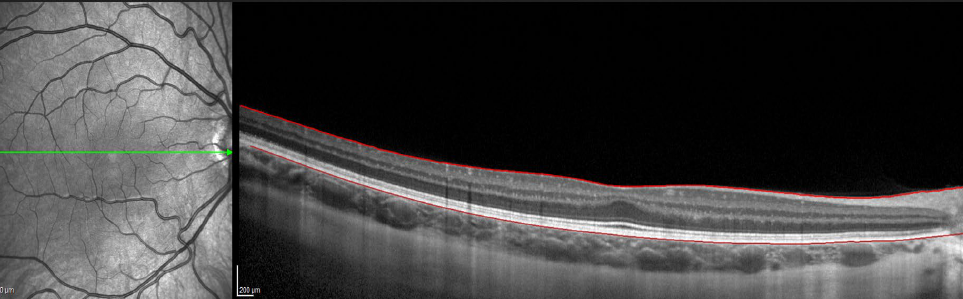
Figure 1. OCT image with lines in red corresponding to the retinal pigment epithelium and the internal limiting membrane.